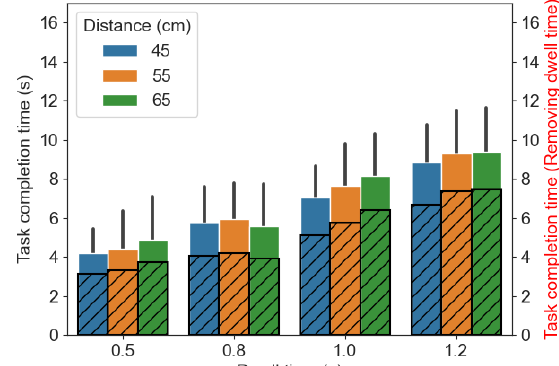
Figure 8. The average task completion time. The error bars represent the standard deviation in each condition. The striped bars are the task completion time after removing the duration of the dwell